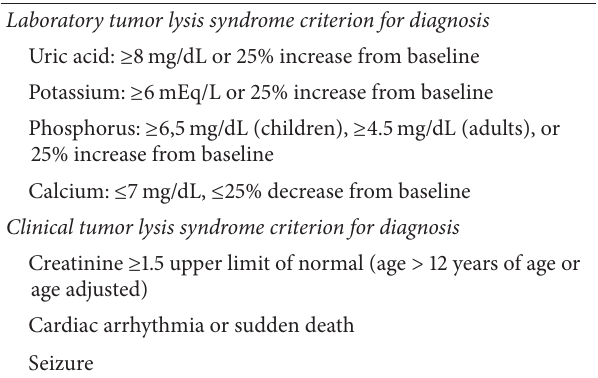
Table 1: 2004 Cairo-Bishop laboratory and clinical criteria for tumor lysis syndrome